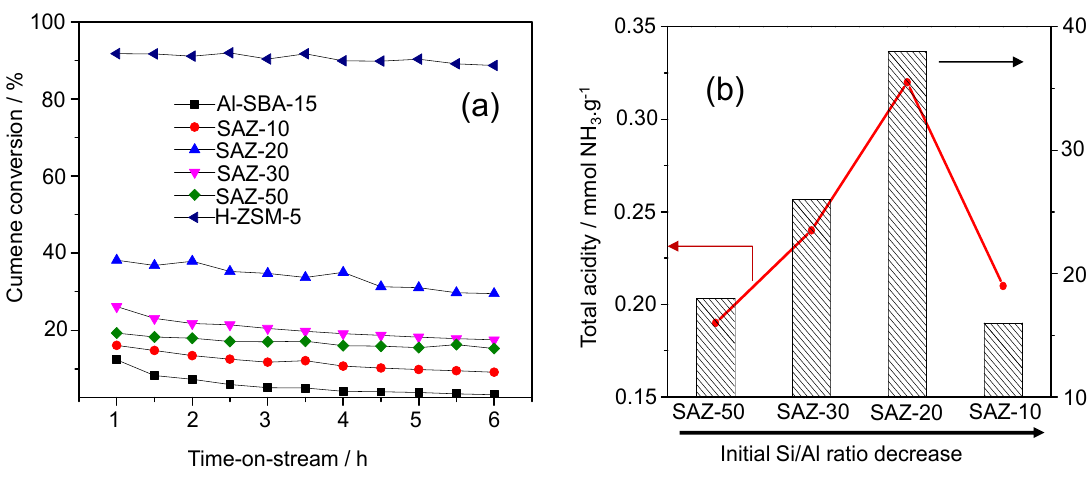
Figure 6. ( a ) Cumene conversion over SAZ materials compared to Al-SBA-15 and H-ZSM-5 as a function of time-on-stream; ( b ) cumene conversion over SAZ materials after 1 h on-stream and their total acidity plotted against the initial Si/Al